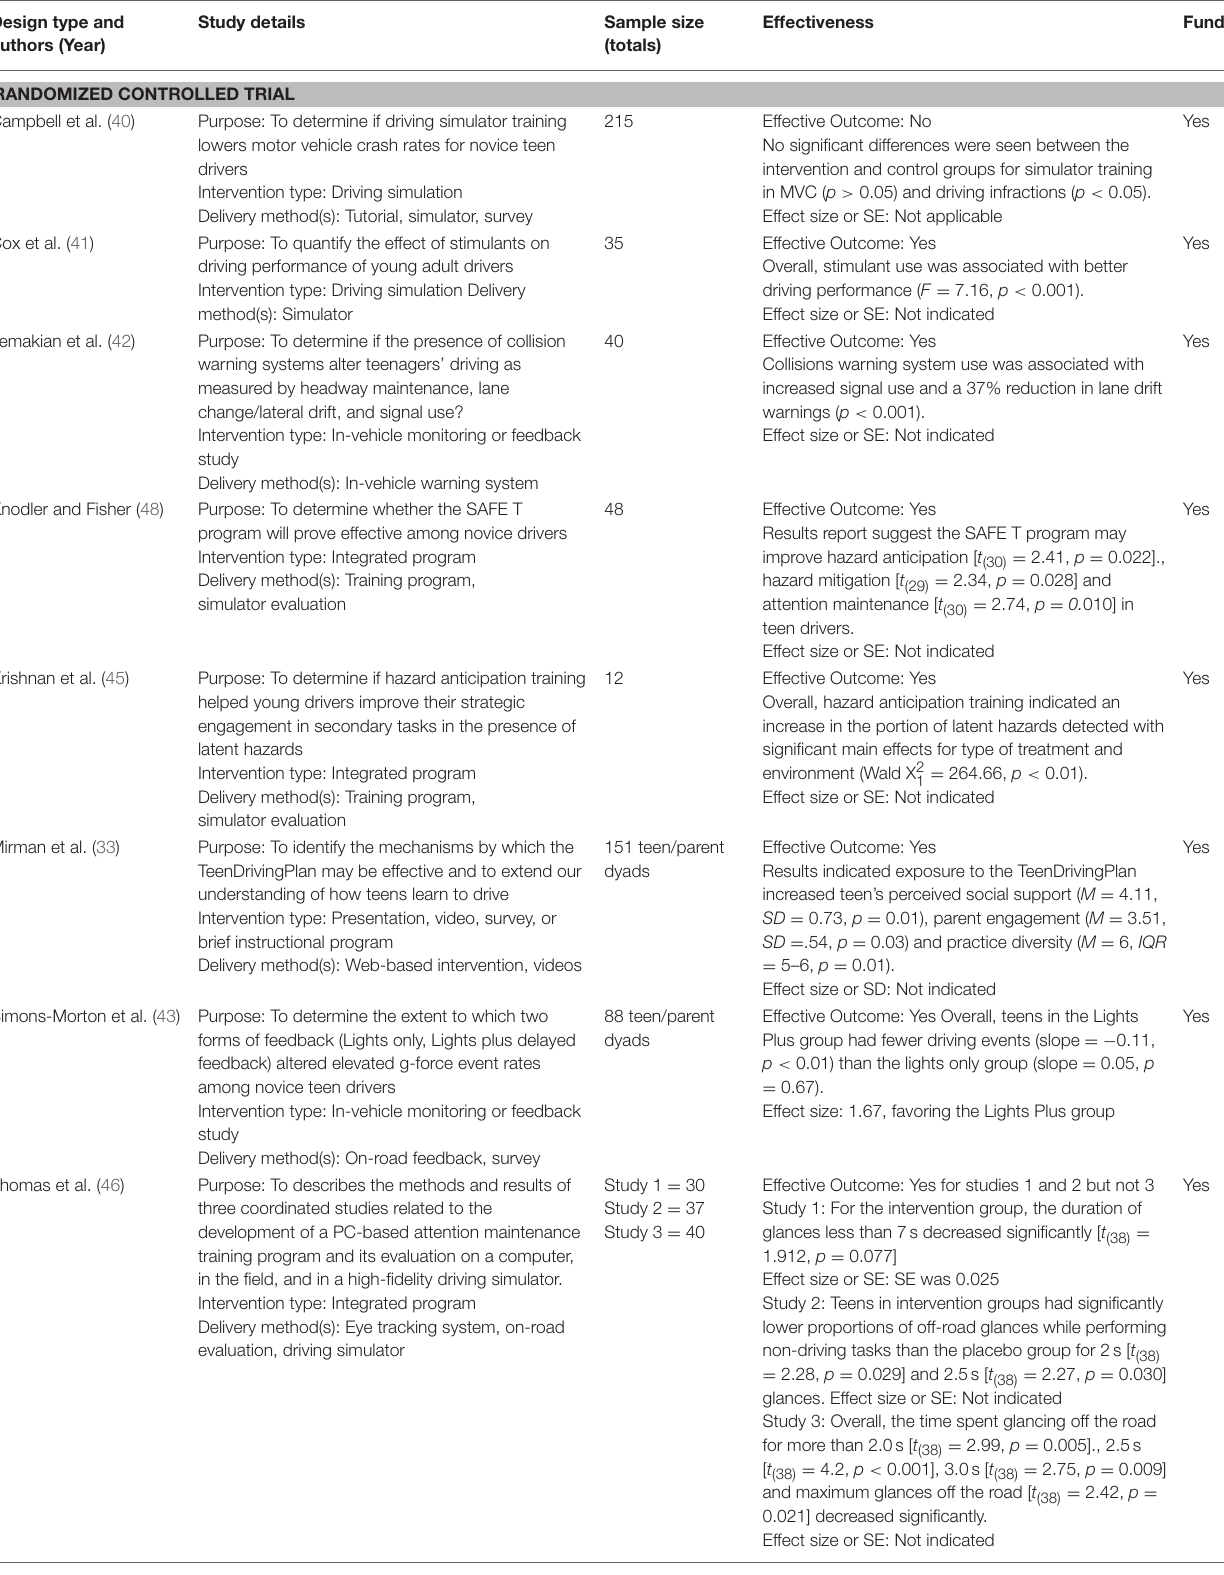
TABLE 3 | Study summaries by design type, author, study details, sample size, effectiveness, funding and outcomes. Design type and authors